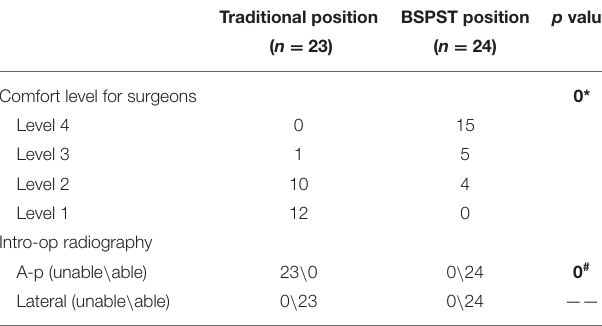
TABLE 3 | C7SP-EOP angle (comfort level for surgeons) and intro-op